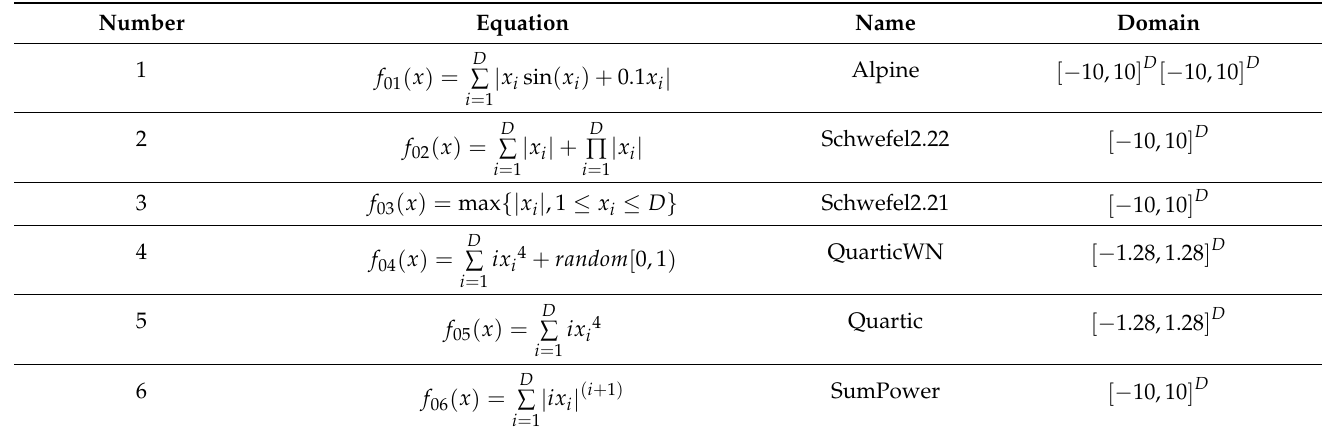
Table 1. Benchmark